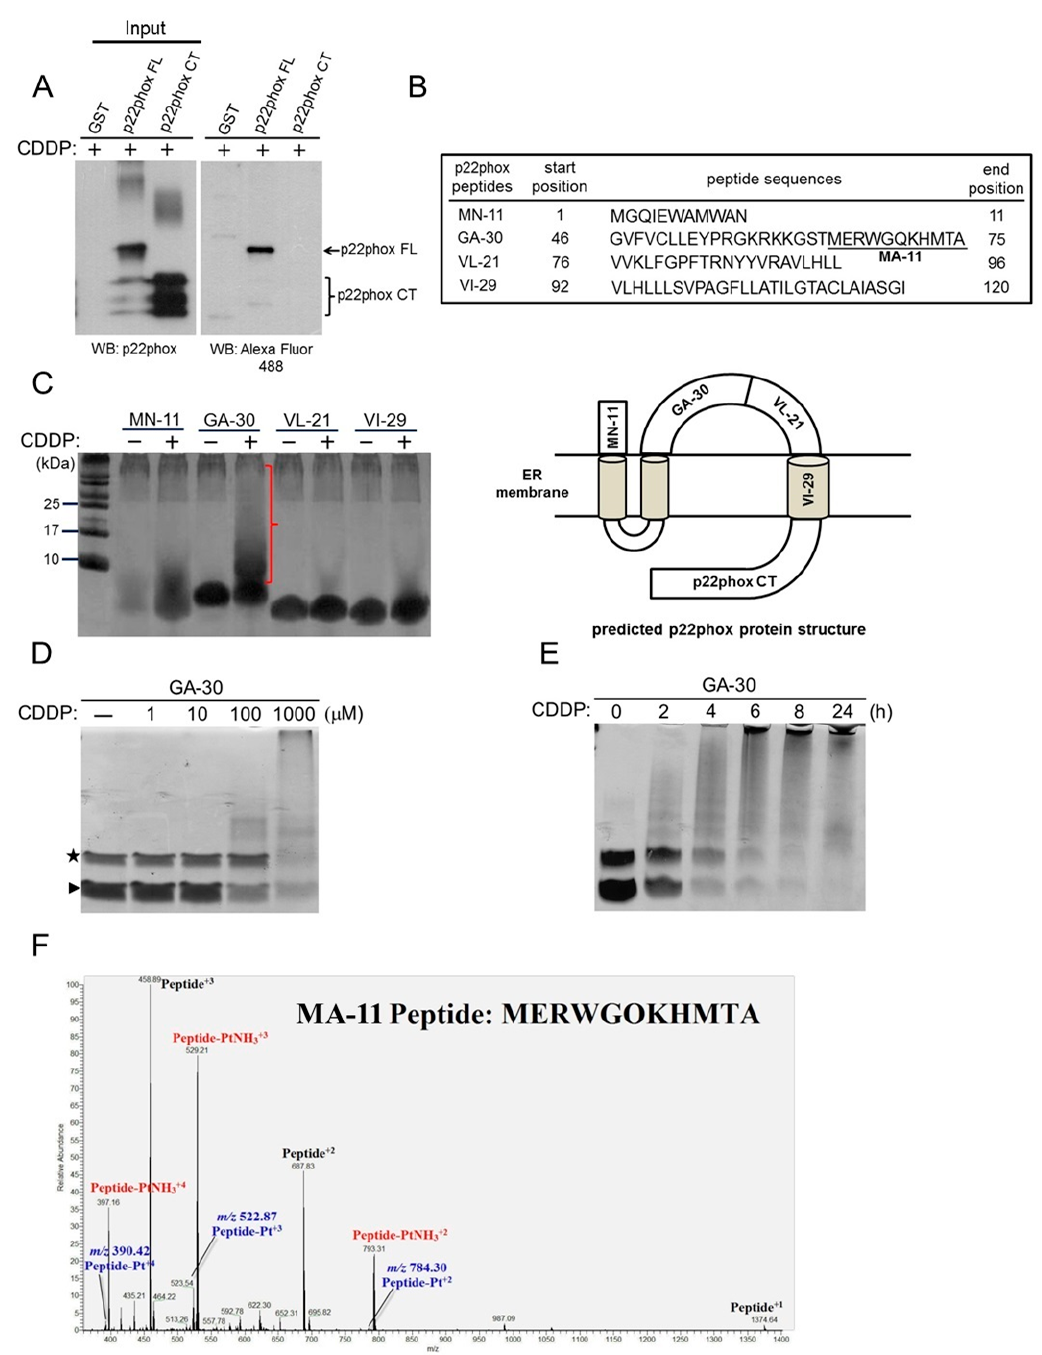
Figure 2. Identification of the CDDP-binding domain in the p22phox protein. ( A ) Binding between p22phox C-terminal domain (p22phox CT) and CDDP was determined using the GST pull-down assay as in Figure 1C. ( B ) (upper panel) The commercially synthesized p22phox peptides and their sequences. (lower panel) The predicted p22phox protein structure and the corresponding locations of the